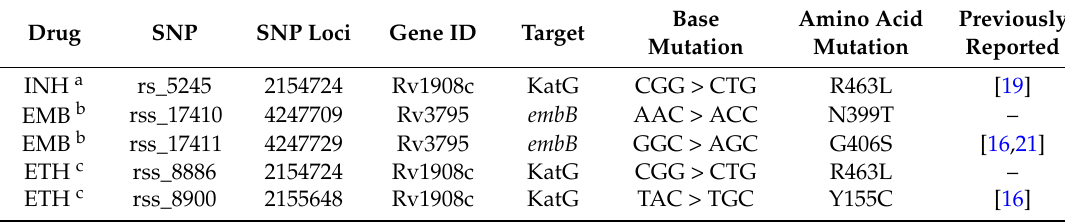
Table 5. The non-synonymous mutations in the target genes from the two